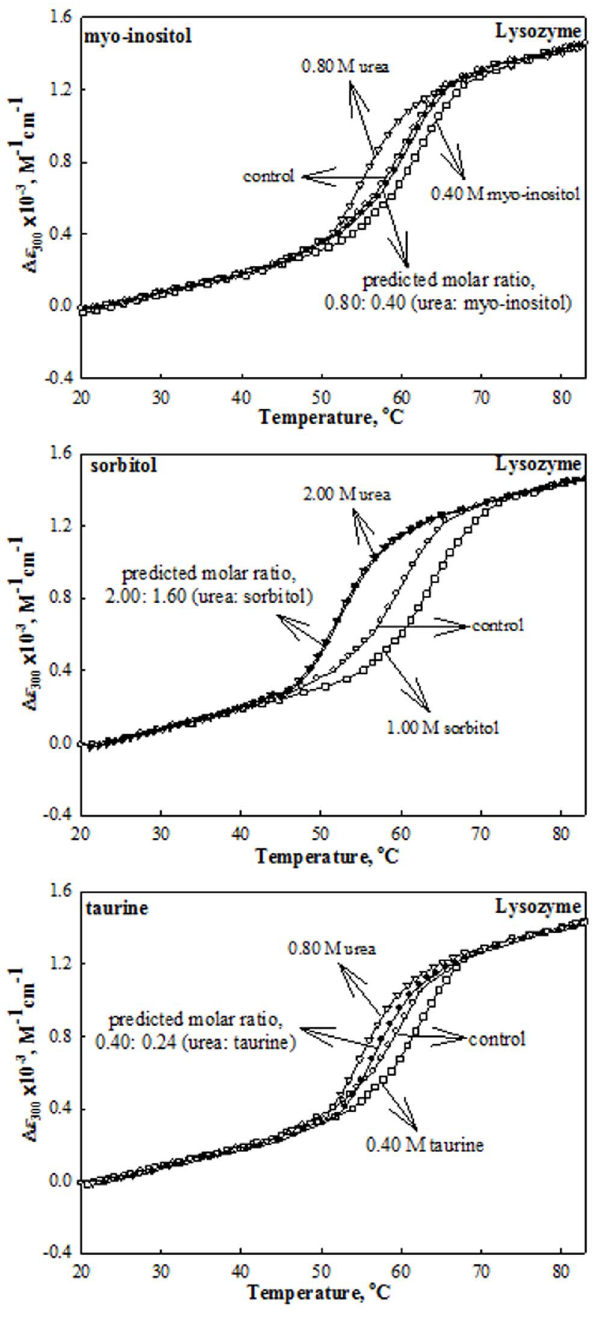
Figure 2. Effect of urea, stabilizing osmolytes and their mixtures (at predicted ratio for perfect counteraction) on Lysozyme at pH 7.0 and 25 6 C. Representative thermal denaturation curves of Lysozyme in the presence of the indicated concentrations of urea, osmolytes and their mixtures at predicted ratios given in Table 2. To maintain clarity all data point and all transition curves are not shown. doi:10.1371/journal.pone.0072533.g002 using cubic dependencies of baselines is an observation that there exists and excellent agreement between a thermodynamic param- eters obtained from such an analysis of the thermal transition curve and from DSC measurements [31,32]. D G D ( T ), the value of D G D at any temperature T was estimated using the known values of T m ,